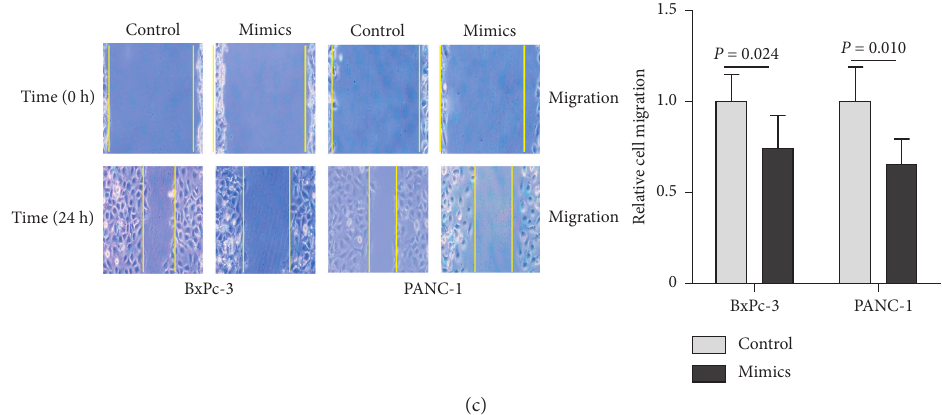
Figure 4: The effect of miR-607 on cell migration and invasion of PDAC cells. (a) Expression levels of miR-607 were detected in BxPc-3 and PANC-1 cells by qRT-PCR after transfection with miR-607 mimics and mimics control. (b) Representative results of cell invasion of PDAC cells by Transwell invasion assay at 24h after cell transfection. Scale bar: 50 μ m. (c) Cell migration ability was determined by a wound- healing assay over 24 h after cell transfection. Results were expressed as mean ± SD for three replicate determination.